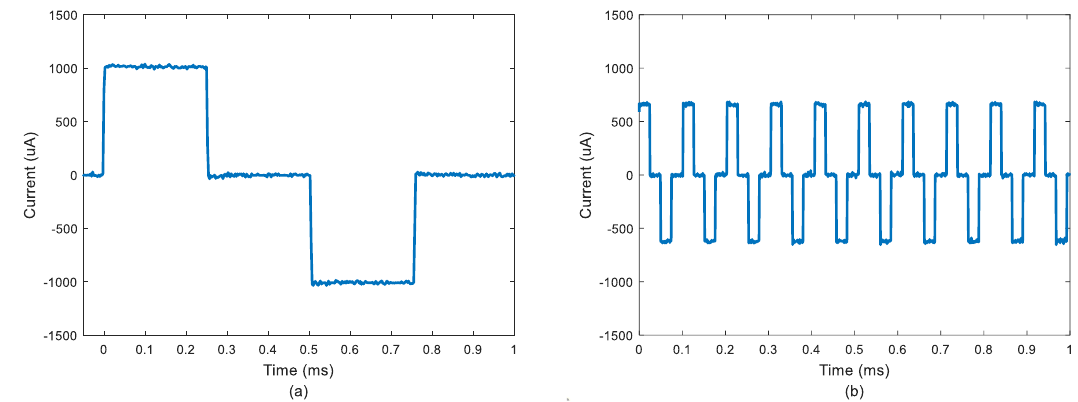
Figure 7. Biphasic stim waveform measured across a 1 k Ω resistive load at ( a ) 1 kHz with 1 mA pulse amplitude and ( b ) 10 kHz with amplitude 0.6